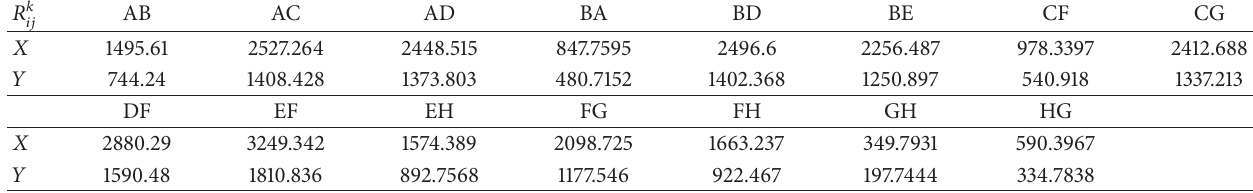
Table 3: Total expected risk.